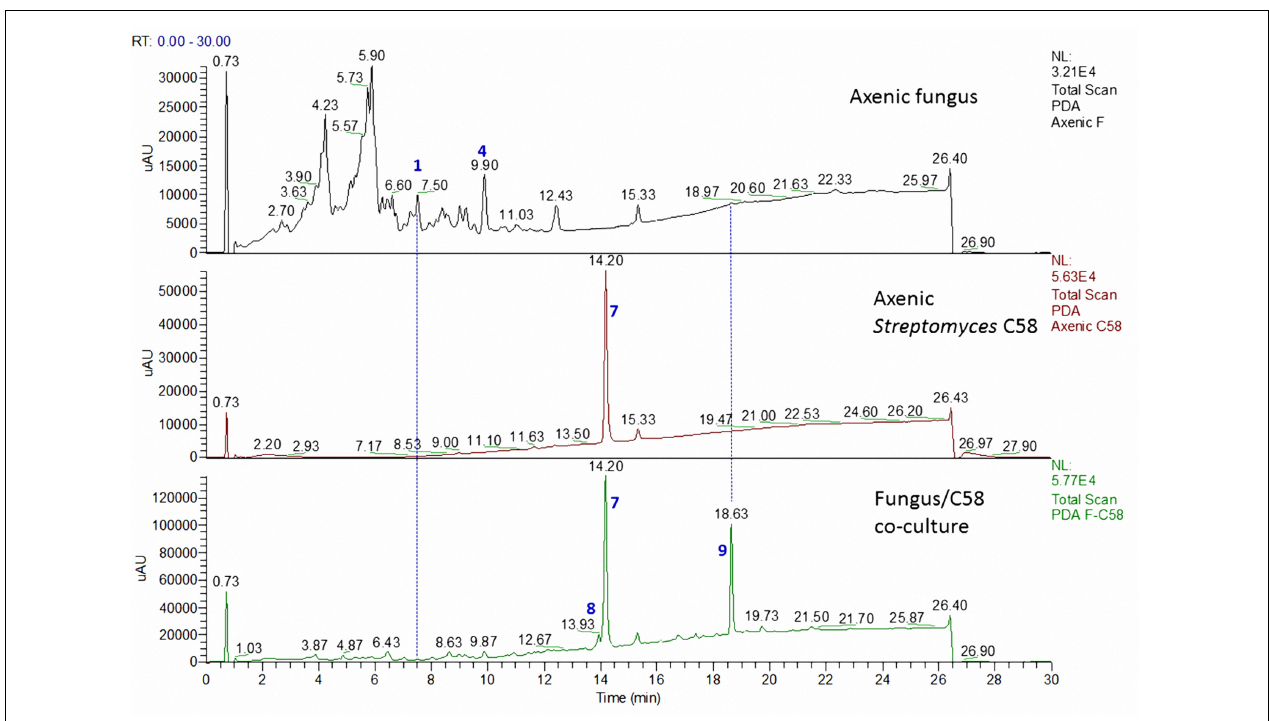
FIGURE 4 | LC comparison of the microbial co-culture of A. fumigatus MR2012 and S. leeuwenhoekii strain C58 on ISP2